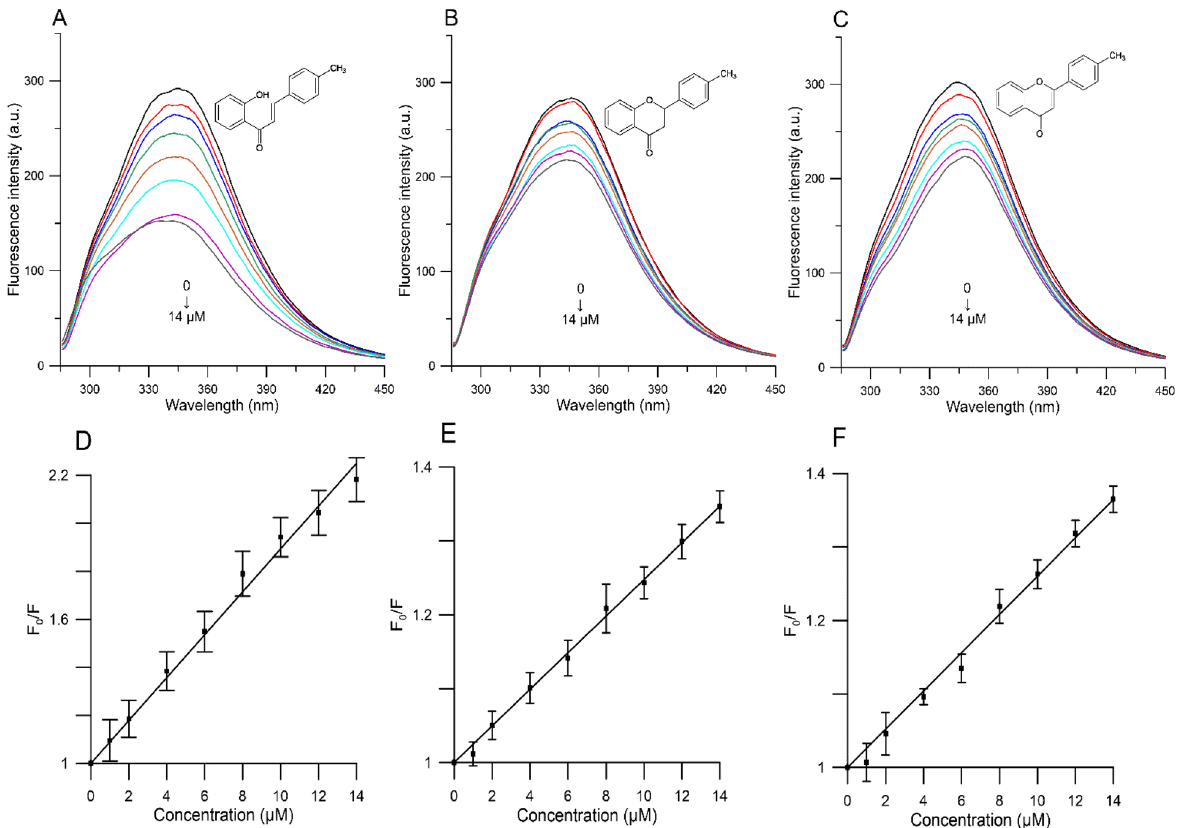
Figure 5. Emission spectra of HSA in the presence of various concentrations of ( A ) 2 ′ -hydroxy-4 methylchalcone, ( B ) 4 ′ -methylflavanone, ( C ) 4 ′ -methylflavone and Stern–Volmer plots of F 0 / F against concentration of ( D ) 2 ′ -hydroxy-4 methylchalcone, ( E ) 4 ′ -methylflavanone and ( F ) 4 ′ -methylflavone. Control is marked black and consecutive spectra of the studied compounds (marked color) are in the following concentrations 1, 2, 4, 6, 8, 10, 12 and 14 µM, λ ex = 280 nm, T = 310